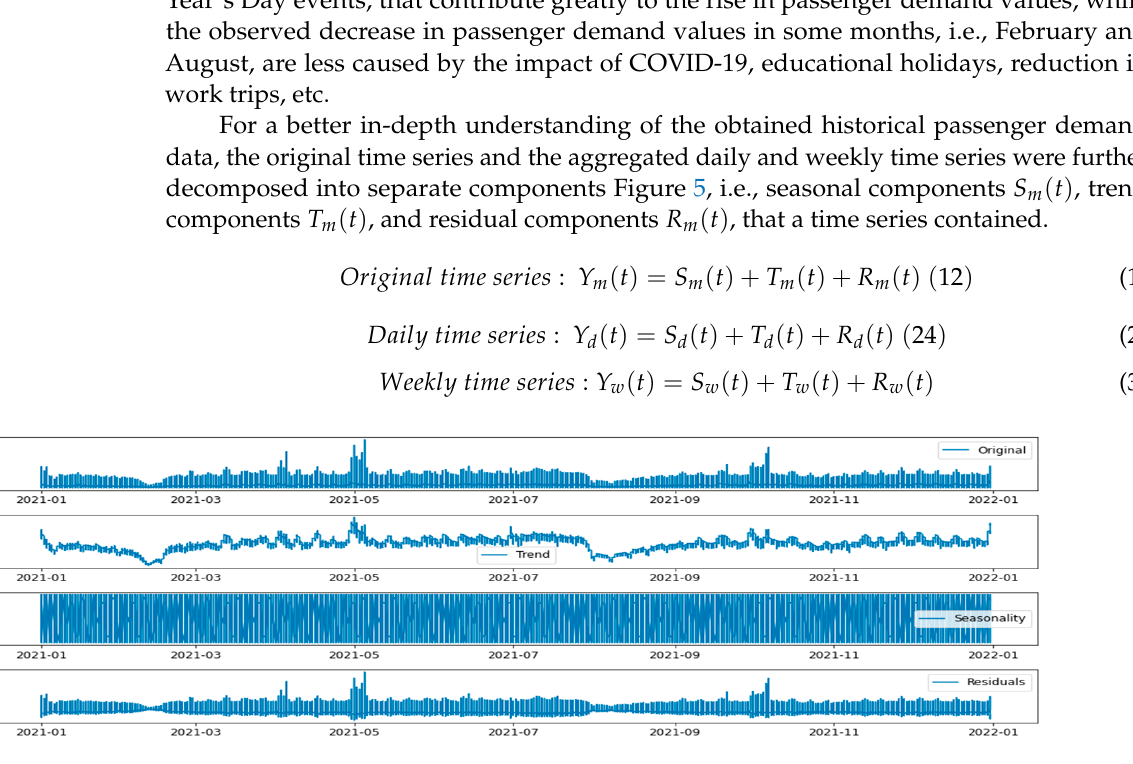
Figure 3. Daily training and testing datasets.